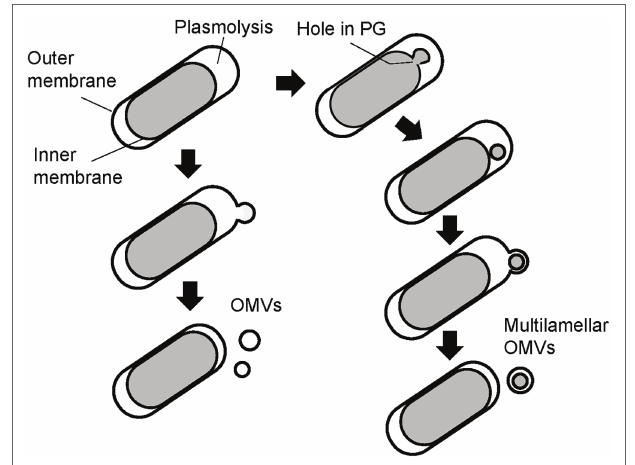
FIGURE 9 | Possible models of the mechanism underlying vesicle formation by Δ mlaE Δ nlpI cells. Left side: model for mechanism in the promoted unilamellar OMV production. Right side: model for mechanism in OIMV